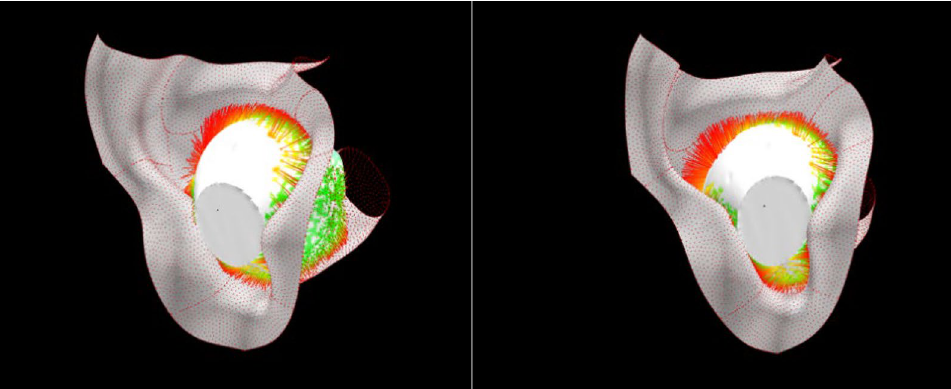
Figure 5. Calculation visual effect between earphone (with only body portion) and ear (with only concha part) in deviation analysis algorithm.